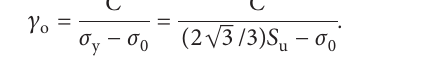
Figure 3: Comparison of FE-computed G − c curve with the ex- perimental curve of Ishibashi and Zhang